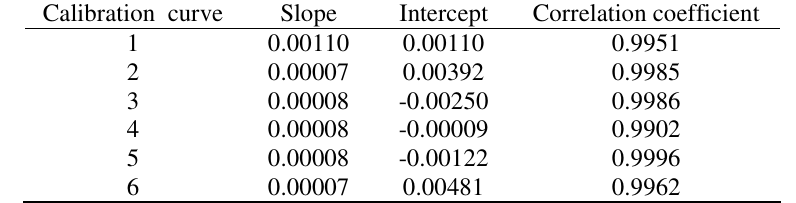
Table 1. Summary of calibration parameters.